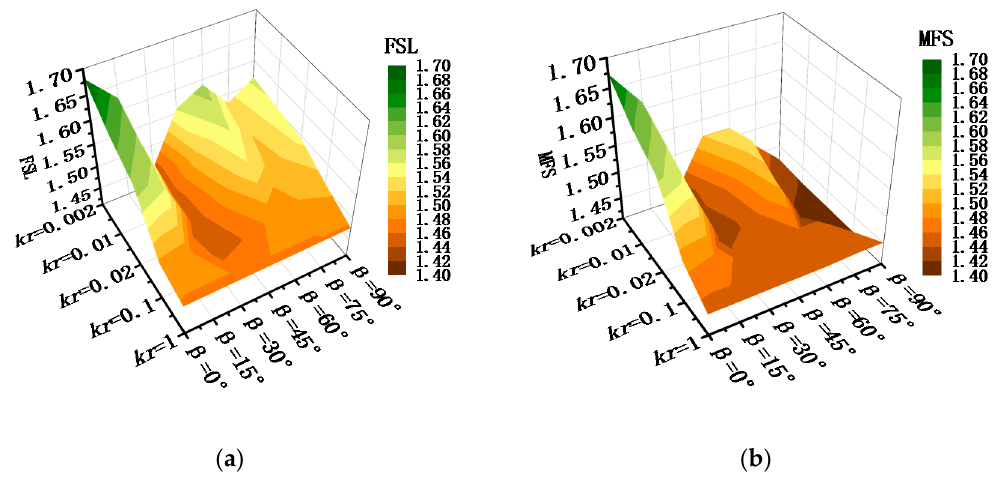
Figure 17. Variations in the factor of safety: ( a ) Factor of safety of landslide (FSL); ( b ) minimum factor of safety (MFS). Table 4. Differences between only considering k r or β and considering both k r and β .